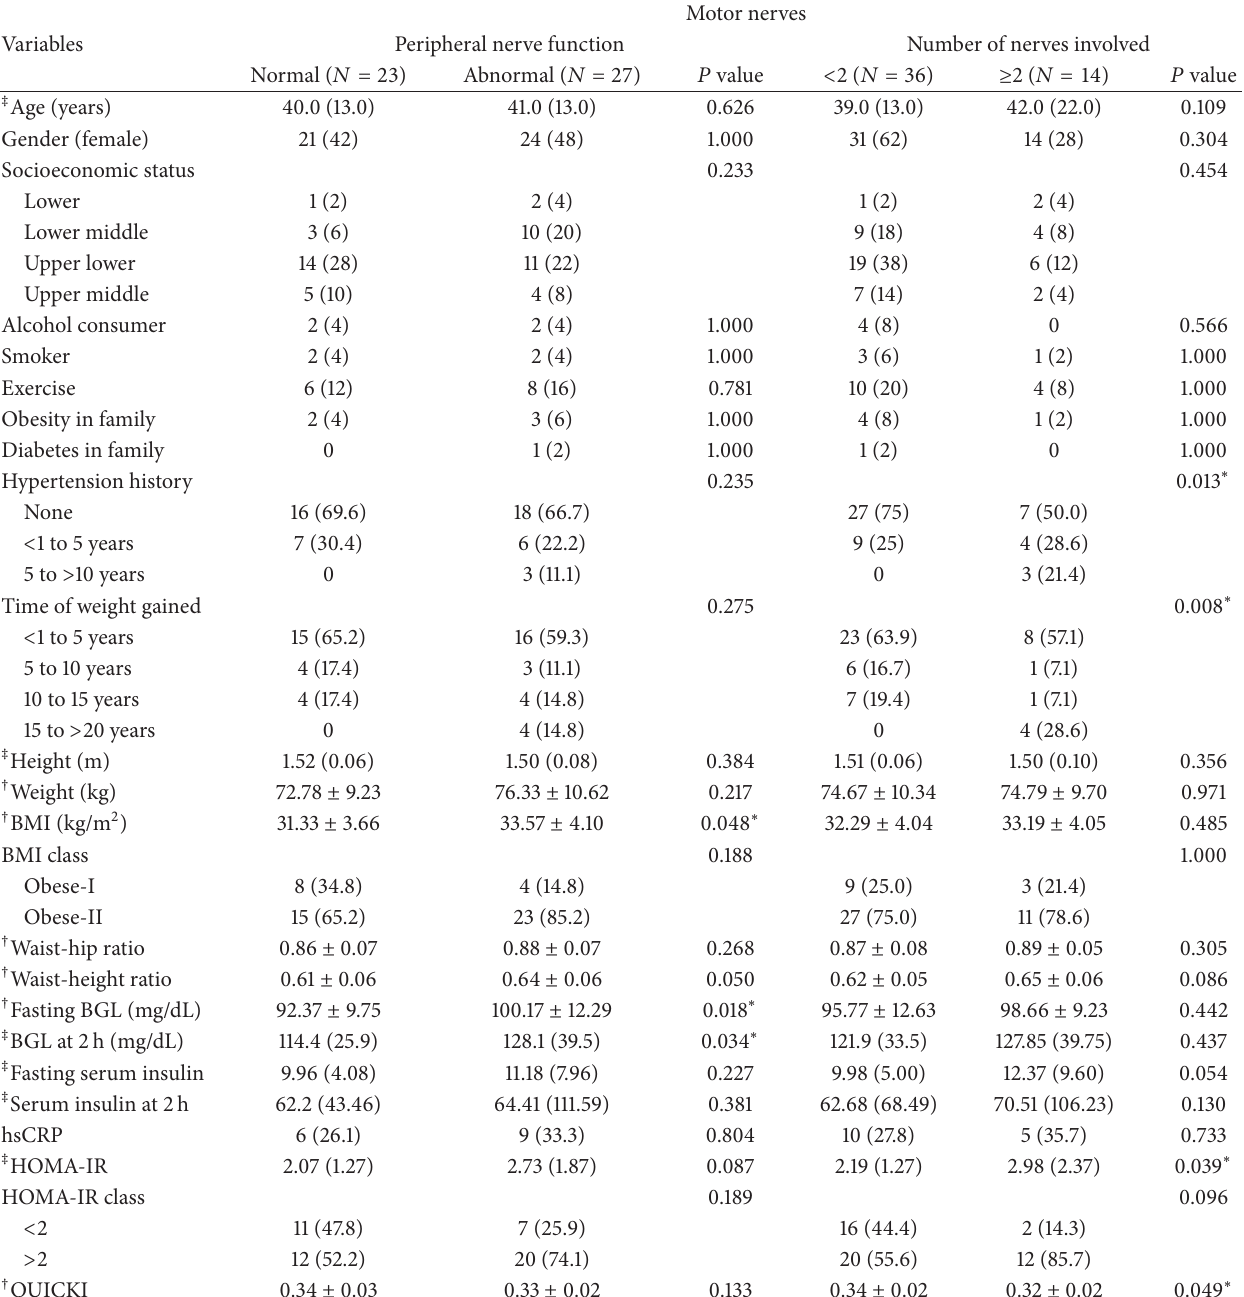
Table 2: Baseline characteristics of volunteers according to the motor nerve. The values in the column of the motor nerves outside the small bracket are the count per total and those inside the bracket are the